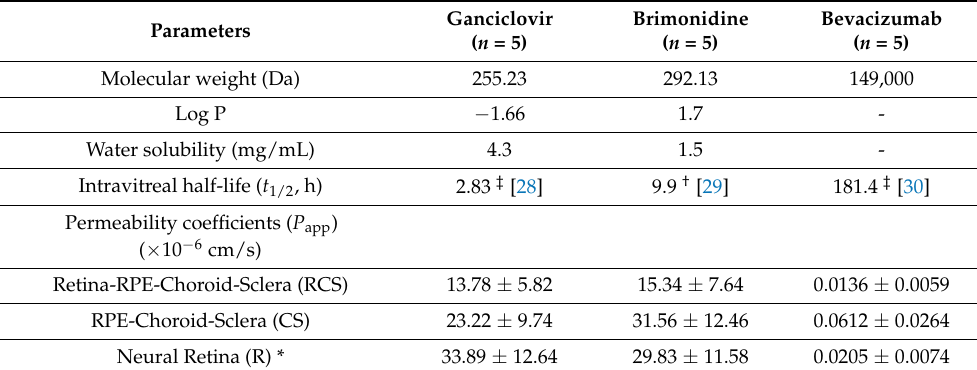
Table 2. Permeability coefficients from the Ussing chamber experiments with rabbit eye tissues.